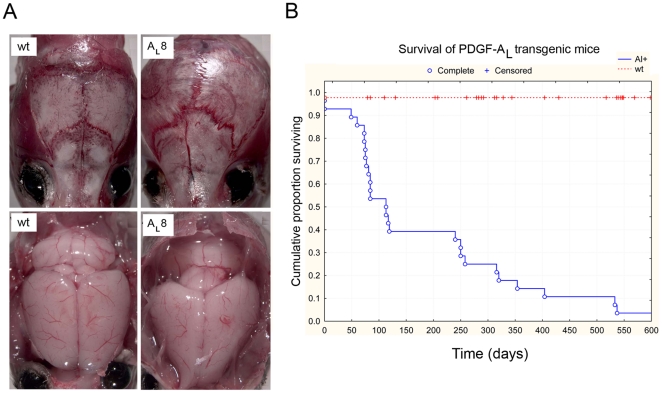
PDGF-AL transgenic mice die from abnormalities in the brain.(A) Skull enlargement as exemplified in PDGF-AL transgenic mice of line 8 (AL8). Compared to wt littermate controls there was an abnormal increase in the amount of fluid in the subarachnoid space situated between the brain surface and the skull in transgenic mice. (B) Kaplan-Meier survival curve showing the life span of transgenic mice that included data from 25 mice of line #8 and the founder mouse #12.